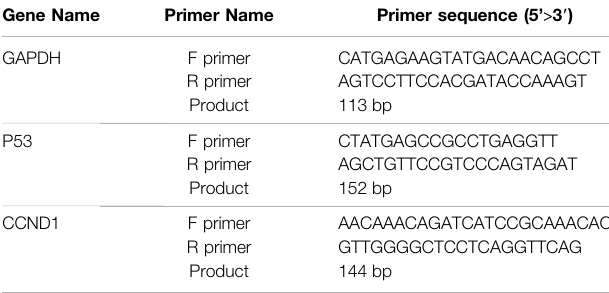
Frontiers in Pharmacology |